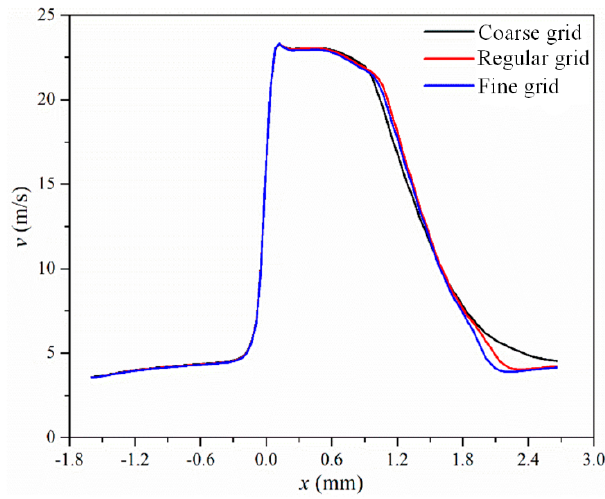
Table 1. Maximum vapor volume fraction under the different grid.